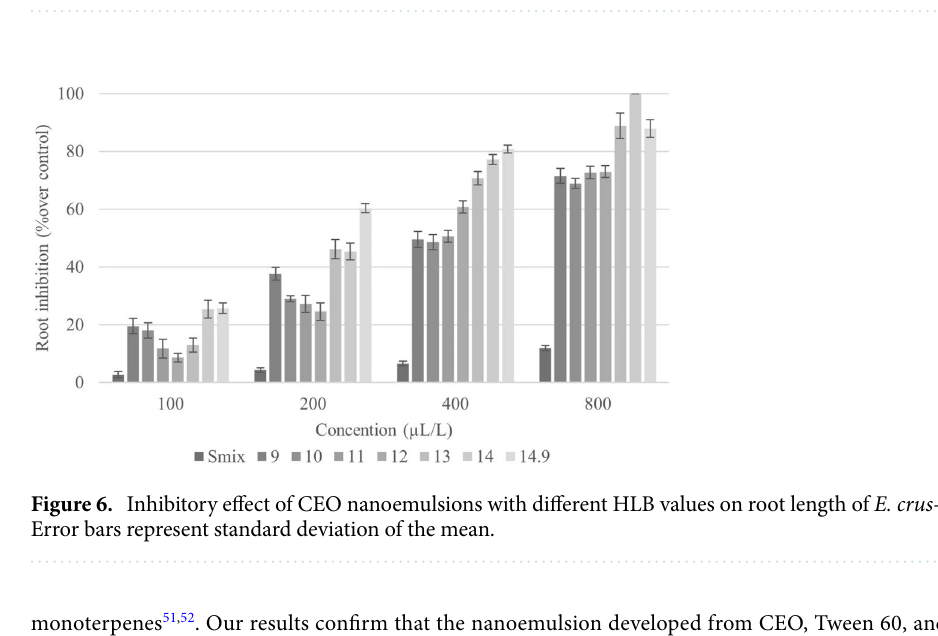
Figure 5. Inhibitory effect of CEO nanoemulsions with different HLB values on shoot length of E. crus-galli . Error bars represent standard deviation of the mean.